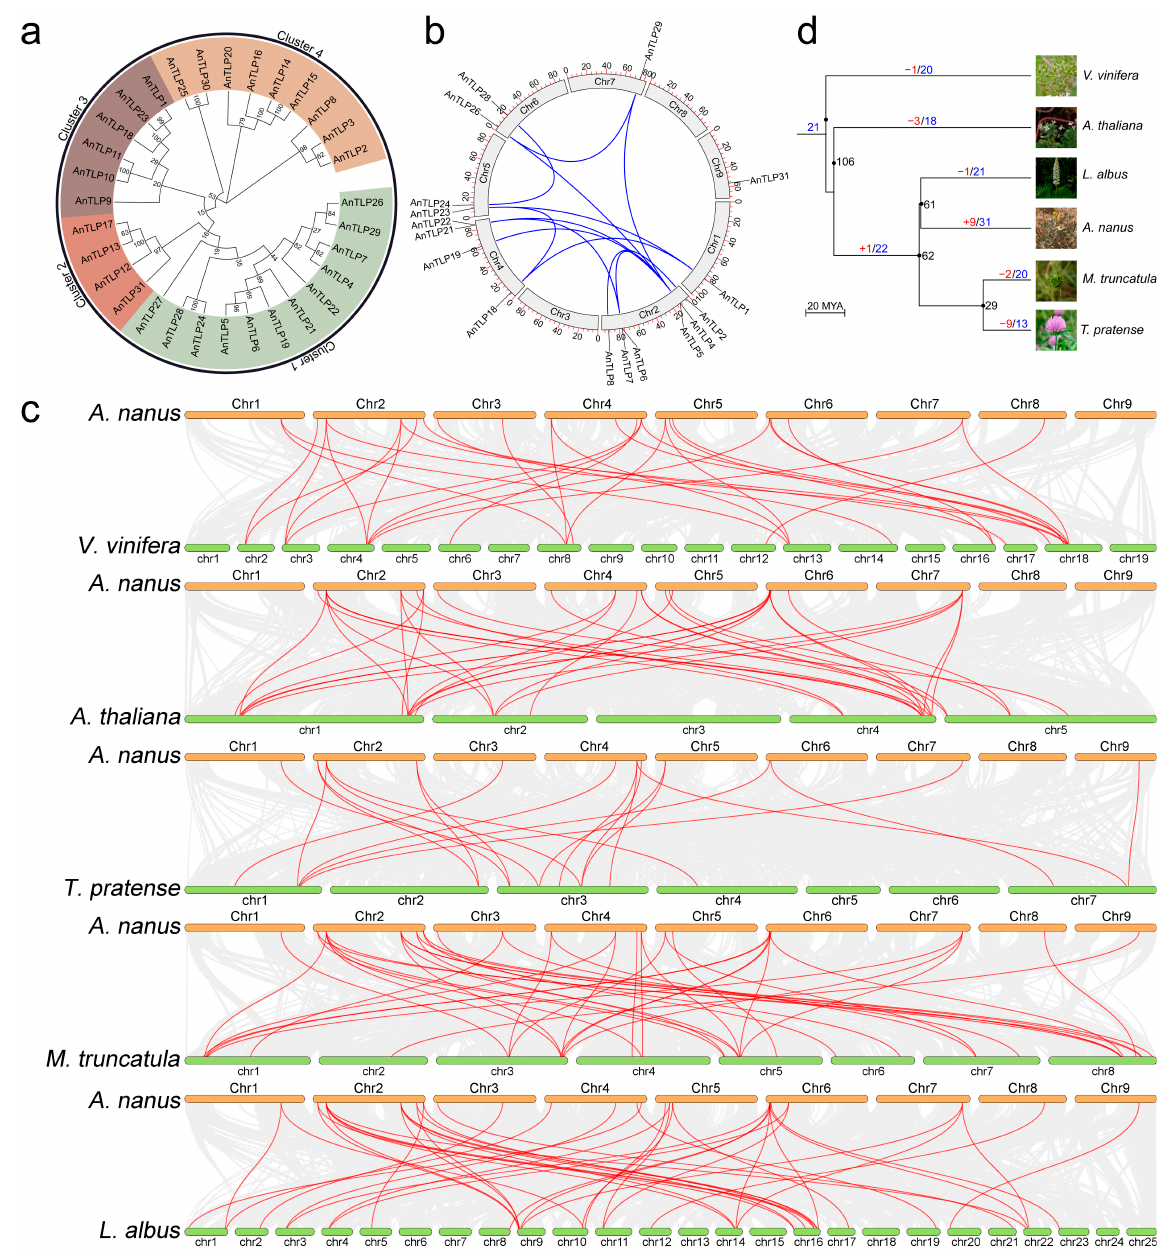
Figure 5. Phylogenetics, gene duplication and divergence of AnTLP genes. ( a ) The phylogenetic tree of AnTLP family. Different colors represented different cluster. ( b ) The distribution of segmental duplication genes of AnTLP on the chromosome of A. nanus . ( c ) Homologous gene pairs between A. nanus and V. vinifera , A. thaliana , M. truncatula , T. pratense , and L. albus , respectively, and the red lines indicate AnTLPs. ( d ) Evolution of TLP gene family in A. nanus and five relative species. Black numbers represent the time of species differentiation, red numbers represent the number of orthologous genes of AnTLP lost or increased during evolution, and blue numbers represent the number of orthologous genes in AnTLP genes. The gene names represented by red and blue numbers are listed in Table S2. The pictures of A. nanus , V. vinifera , A. thaliana , M. truncatula , T. pratense , and L. albus were obtained from the Plant Photo Bank of China (PPBC).